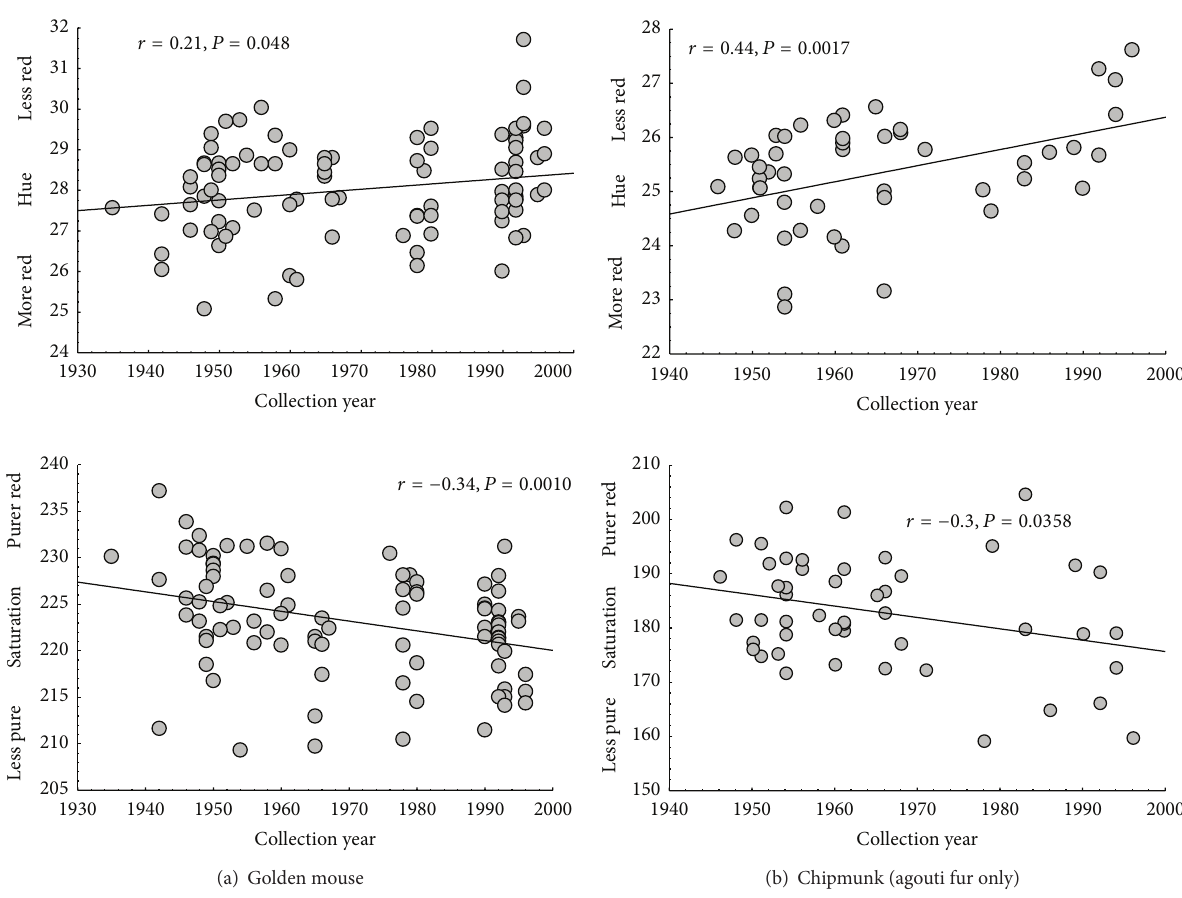
Figure 2: Relationships between storage time (collection year) and pelage color (hue and saturation) for golden mice (a) and chipmunks (b). Only the values from the agouti pelage of chipmunks are shown. There was no temporal effect on the white and black stripes of